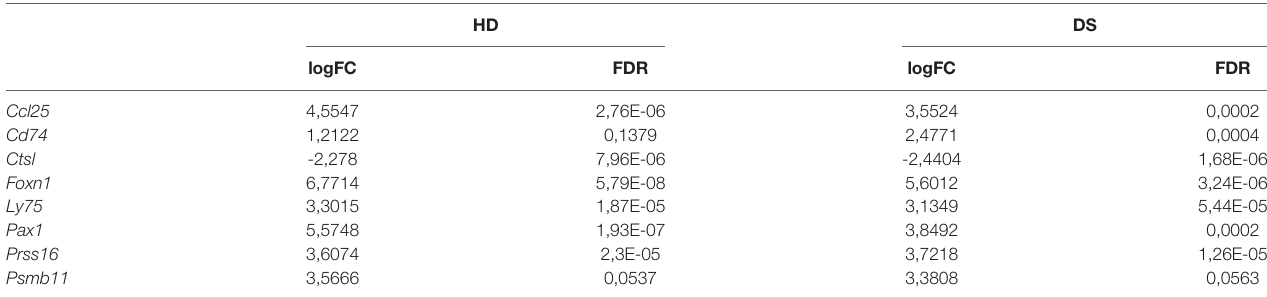
TABLE 1 | Differential expression of cTEC-speci fi c genes.